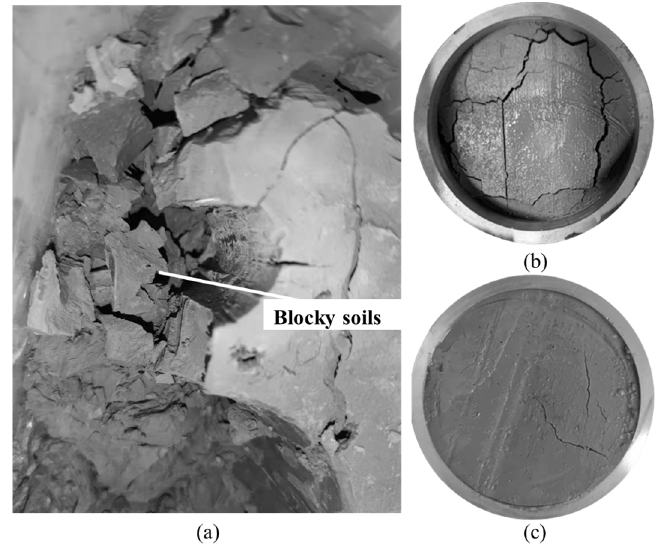
Figure 8. Soil after treatment with or without water immersion. ( a ) EO-treated soil without water immersion. ( b ) Surface of EO-treated soil after water immersion. ( c ) Surface of VP-treated soil after water immersion .